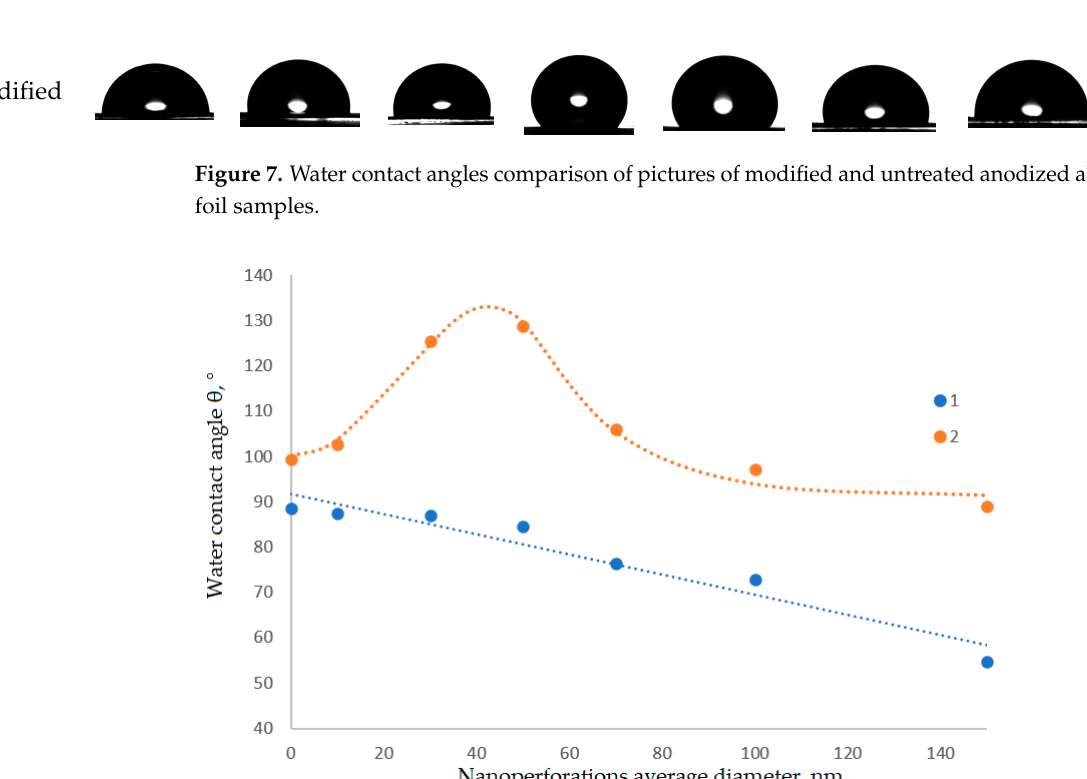
Figure 8. Water contact angle dependence of nanoperforation average diameters, 1–untreated anodized aluminum, 2–modified aluminum.